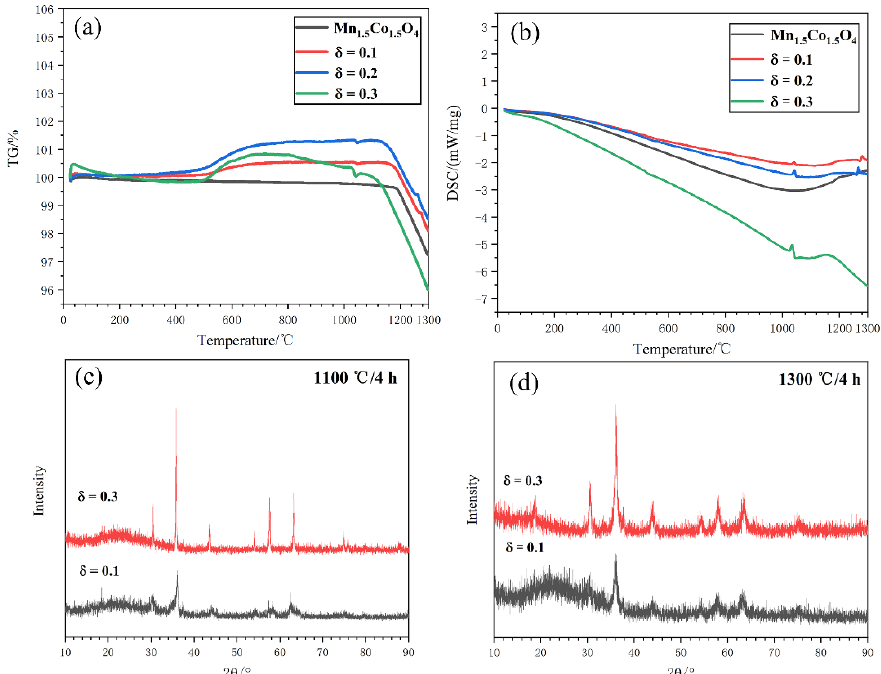
Figure 4. ( a ) TG curves of Cu δ Mn 1.5 − x Co 1.5 − y O 4 powders; ( b ) DSC curve; ( c ) XRD patterns of powder sintered at 1100 ◦ C for 4 h with δ = 0.1 and 0.3; ( d ) XRD patterns of powder sintered at 1300 ◦ C for 4 h with δ = 0.1 and 0.3.